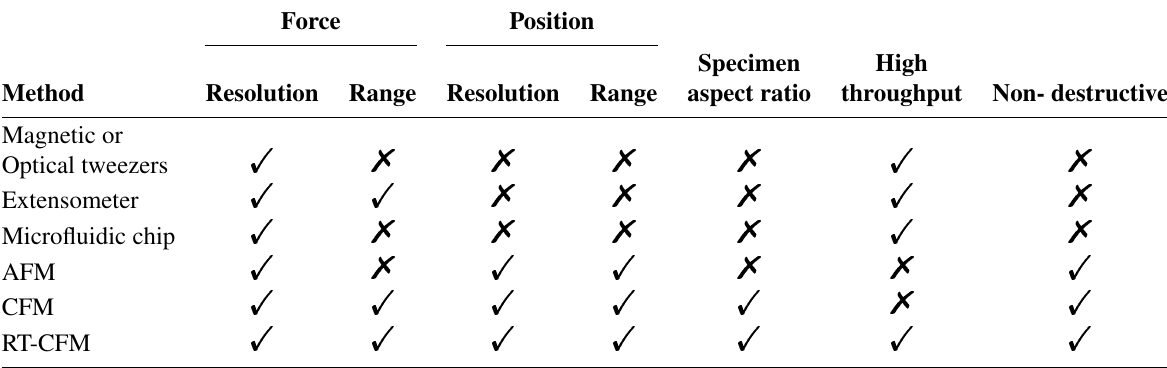
Table 1. Advantages and disadvantages of mechanical characterization